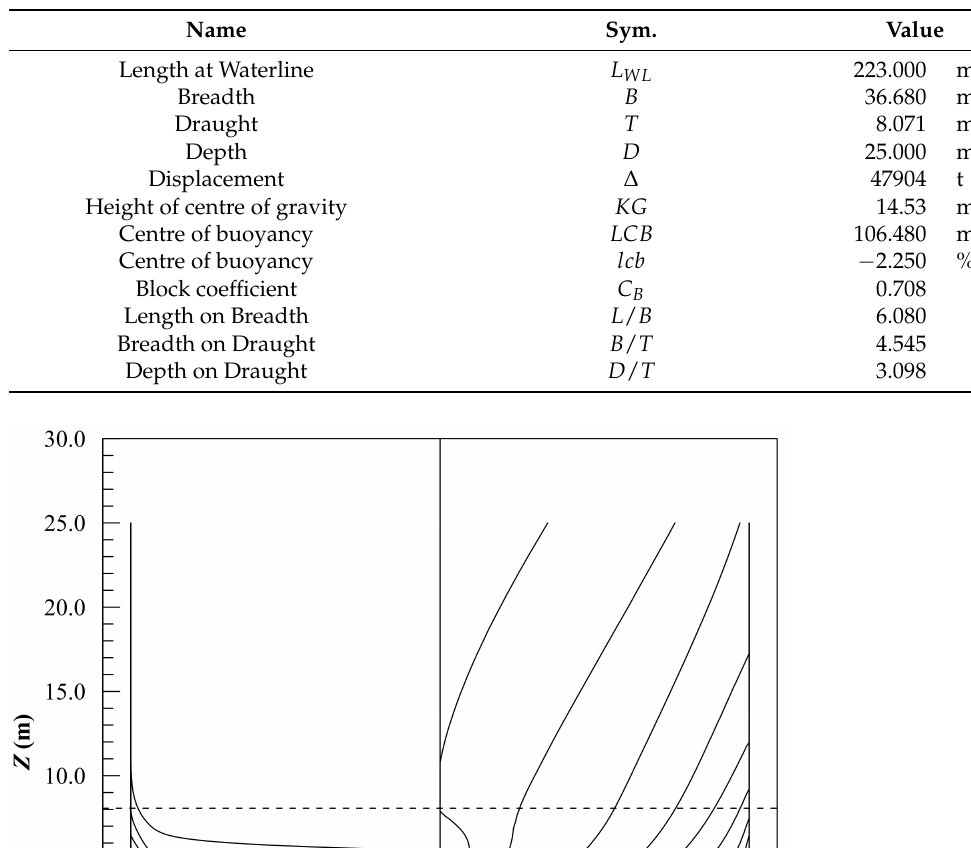
Table 2. Main particulars of the test ship.